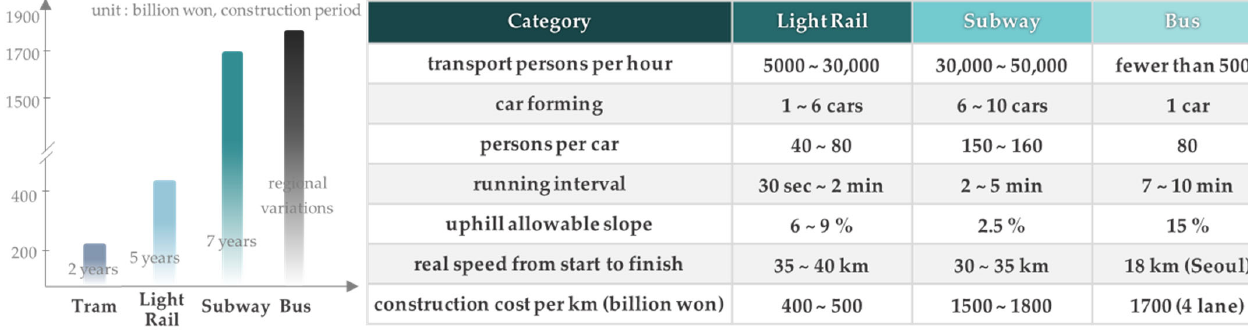
Figure 1. Construction cost per 1 km of public transportation (Seoul metro, 2017, Ministry of Land, Infrastructure and Transport, 2018).